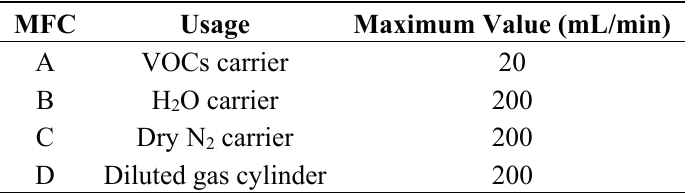
Table 1. MFC usage and maximum